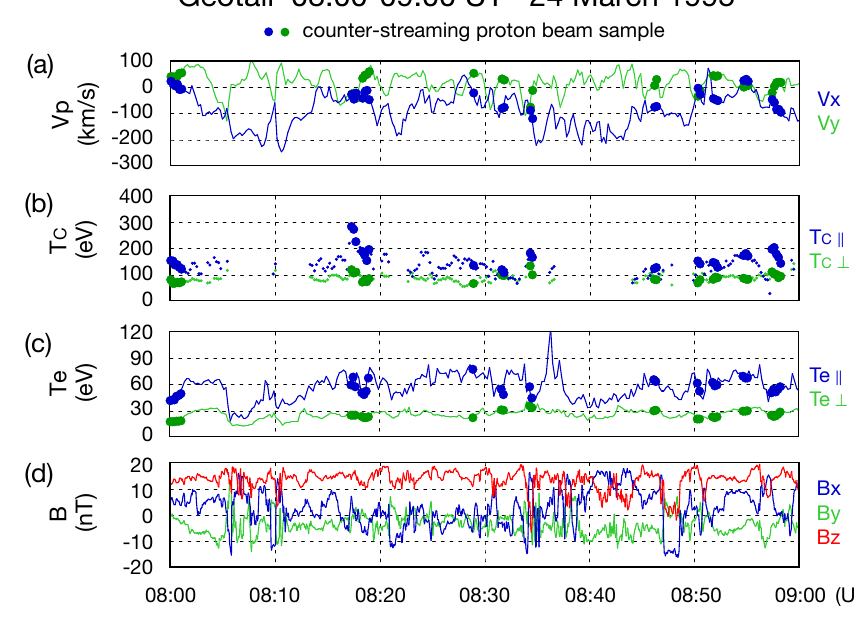
Fig. 10. Counter-streaming proton beam samples observed between 08:00–09:00 UT. The large circles correspond to the counter-streaming proton beam samples. From the top, (a) proton velocity, (b) temperatures of the cold proton component (data in the stagnant region are shown), (c) electron temperatures, and (d) magnetic field are